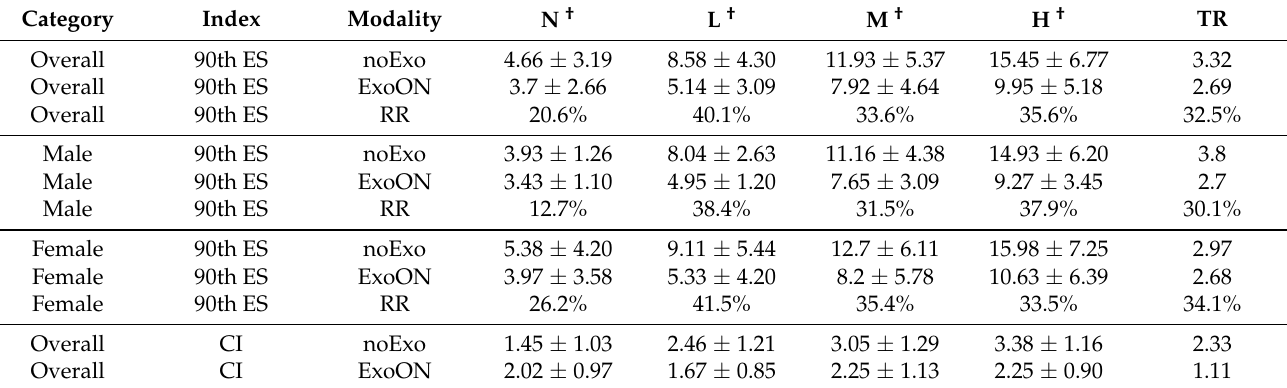
Table 2. Summary of the results and descriptive statistics (mean ± STD) due to the exoskeleton effect for the 0 ◦ trunk inclination. (†) the unit is [%MVC], RR stands for Reduction Rate, and TR stands for Trend.